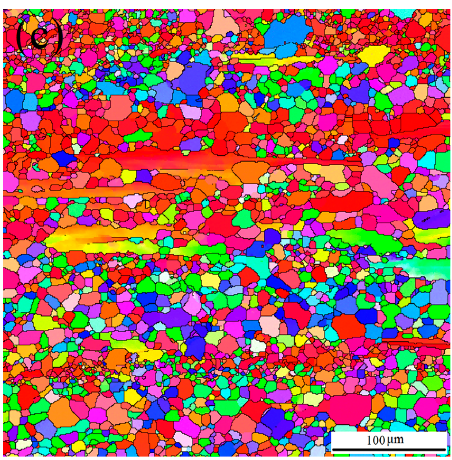
Figure 6. Inverse pole figure maps of as-extruded Mg-Sn alloys obtained by electron backscattered diffraction (EBSD, along the extrusion direction): ( a ) Mg-6Sn; ( b ) Mg-6Sn-2Zn; and ( c ) Mg-6Sn-2Zn-1Ca.